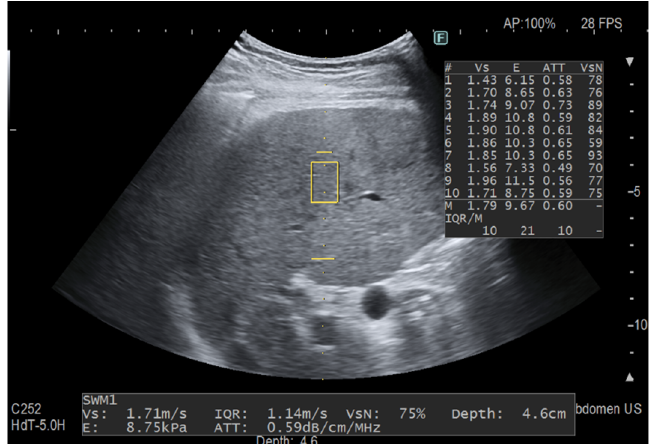
Figure 2. Fat quantification with iATT. The two horizontal yellow lines graphically show the width (length of each line) and the length (distance between the two lines) of the iATT measurement area, which has a fixed size (length of 4 cm, from 35 to 75 mm from the skin). The measurement of the attenuation coefficient is given in dB/cm/MHz together with liver stiffness measurement. The yellow rectangle is the region of interest (ROI) for stiffness measurement. This measurement was taken in a 58-year-old patient with primary biliary cirrhosis but not steatosis.